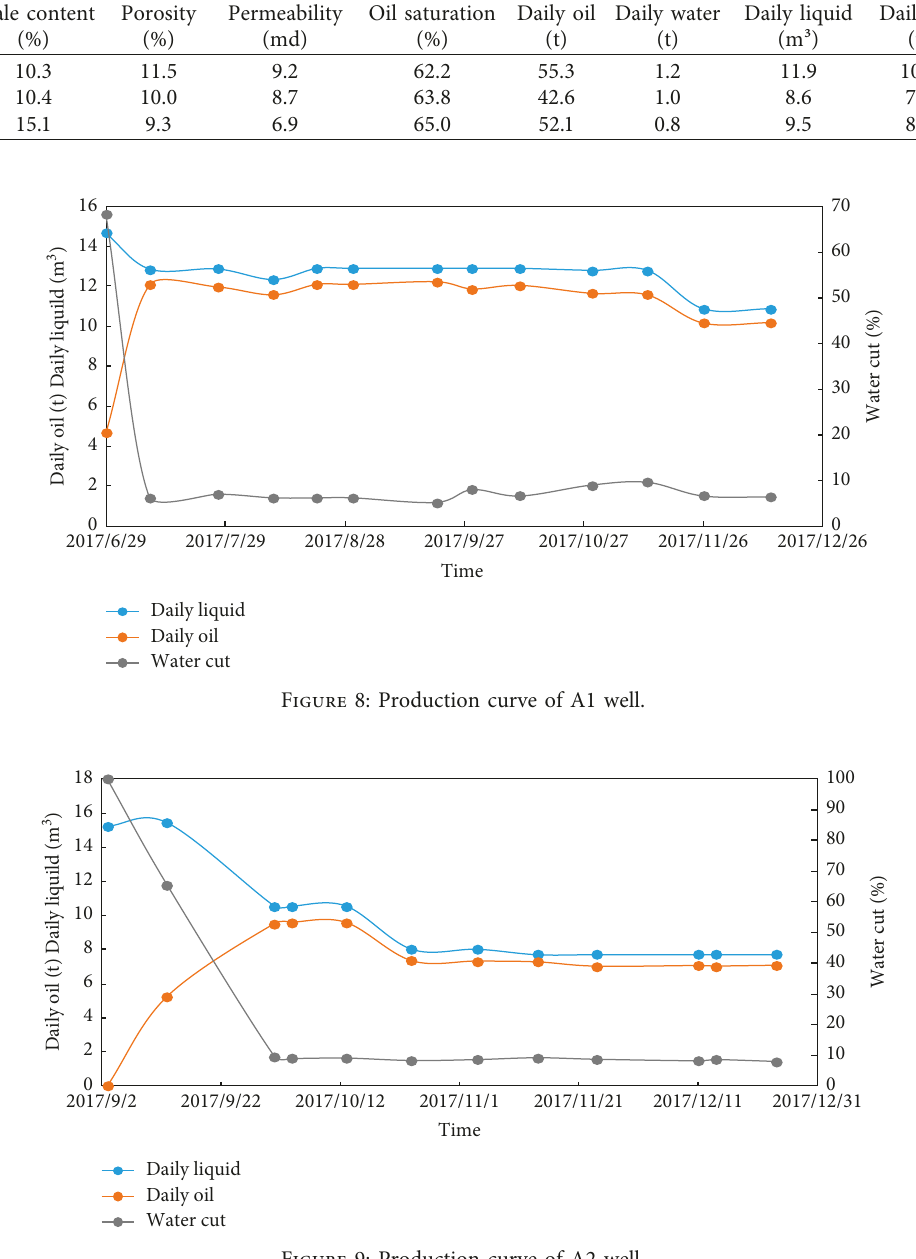
Figure 9: Production curve of A2